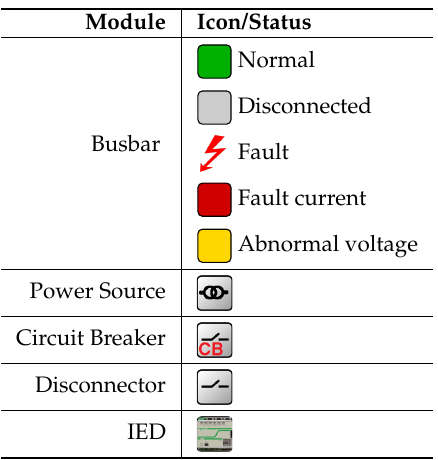
Table 1. Developed OMNeT++